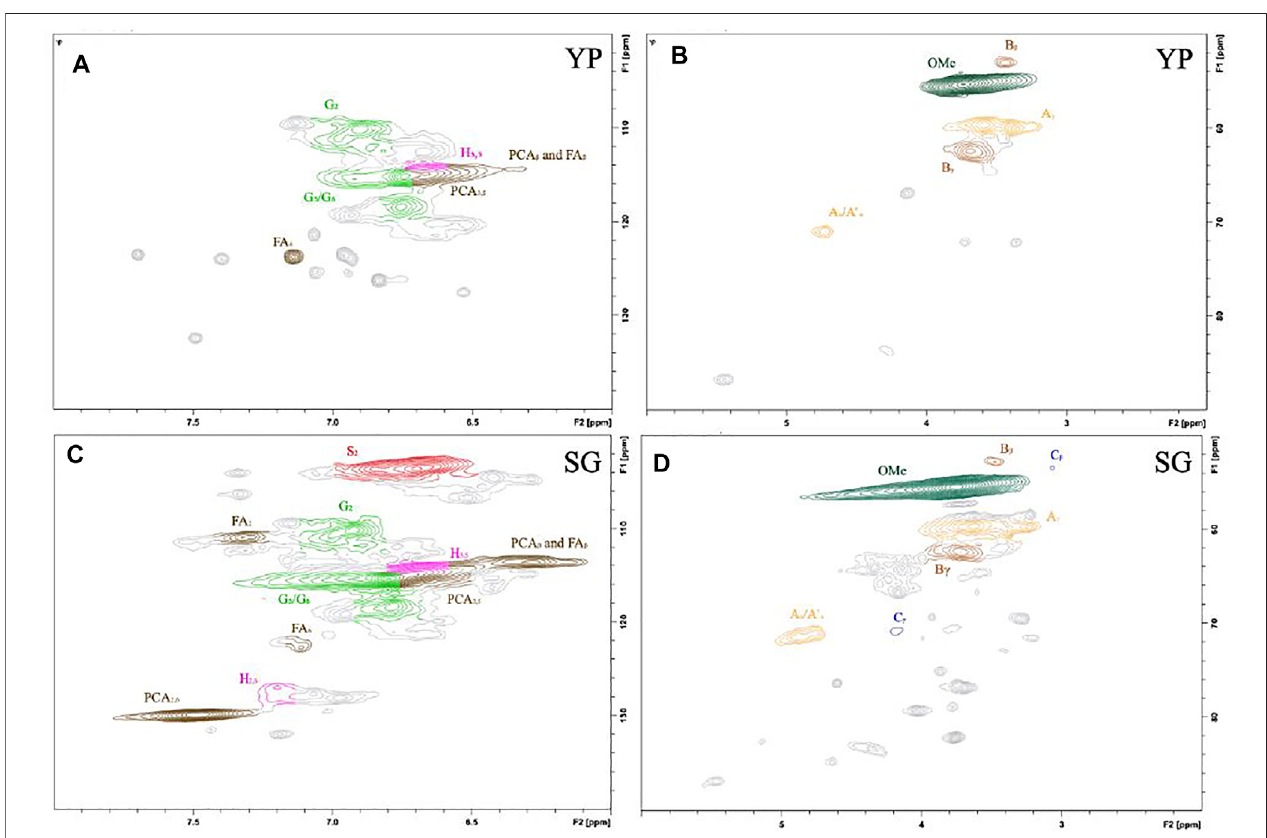
FIGURE 3 | 2D 13 C- 1 H NMR spectra for different lignin precursors (A,B) YP and (C,D) SG.